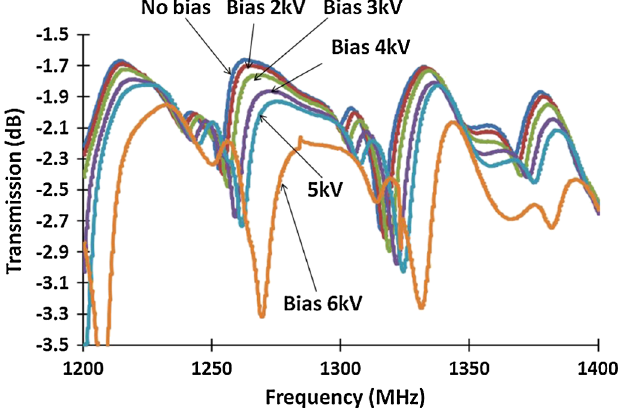
FIG. 10. The signal from the rf generator at 1290 MHz is split in two. One portion is directed through a phase shifter and attenuator directly to a mixer, while the second portion is fed through the tuner input port, passes through the tuner, picked up at the tuner output port, and then is fed to the mixer. The resulting signal from the mixer is detected by a diode and monitored at an oscilloscope, and also captured by a computer for further signal processing [mainly via fast Fourier transfor- mation (FFT)].